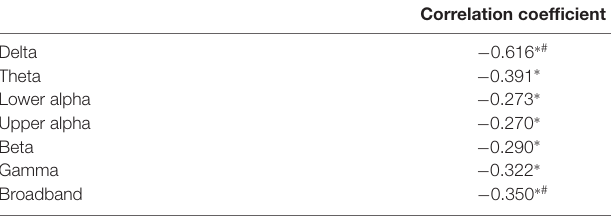
TABLE 2 | Summary of correlations between PMA during recording and PLI.